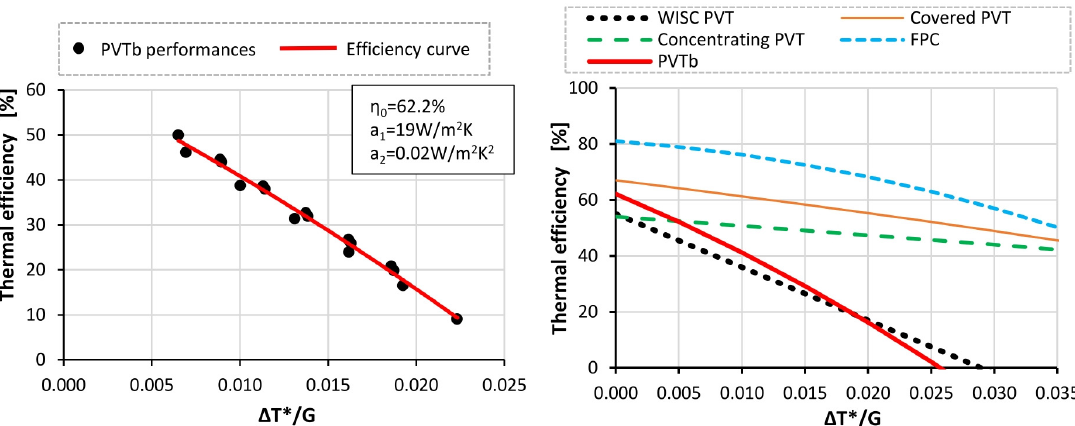
Figure 6. Thermal efficiency curve of the studied bi-fluid PV/T (left) and comparison of efficiency curves of several PV/T panel technologies (right).